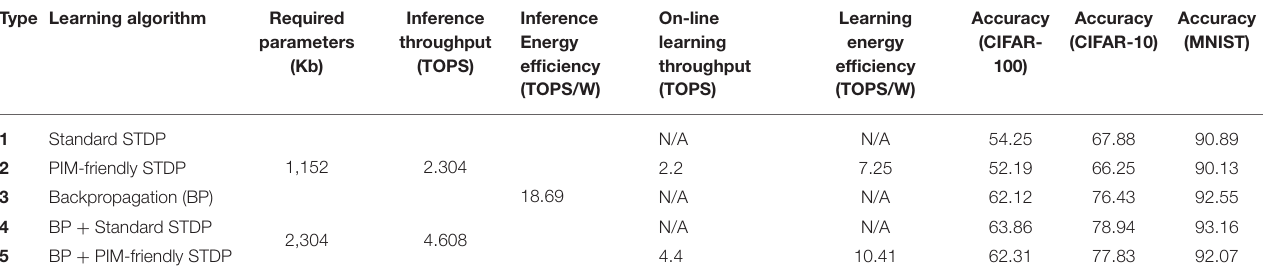
TABLE 2 | Simulated network types and the results. Type Learning